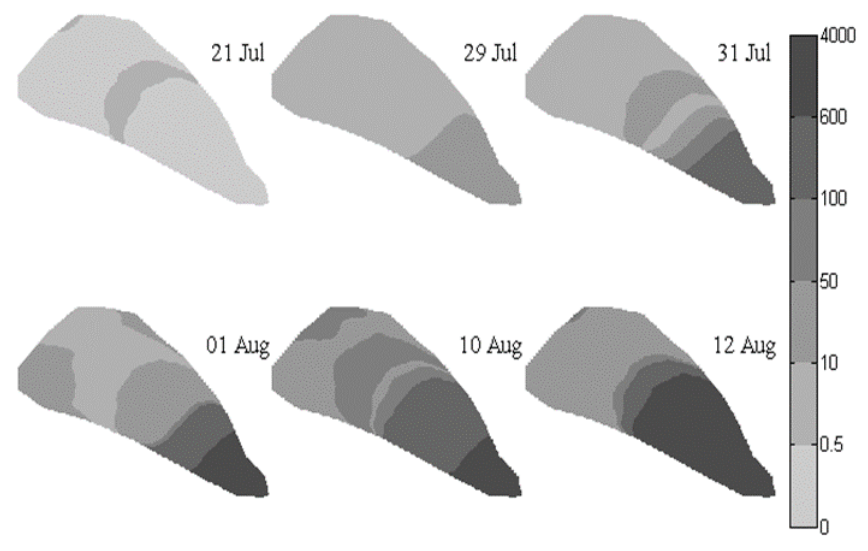
Figure 3. Spatiotemporal variations in dust concentrations (ppm) recorded in surface snow over the QT No. 1 Glacier from 21 July to 12 August in 2013. Not all data are shown due to a limited number of samples.